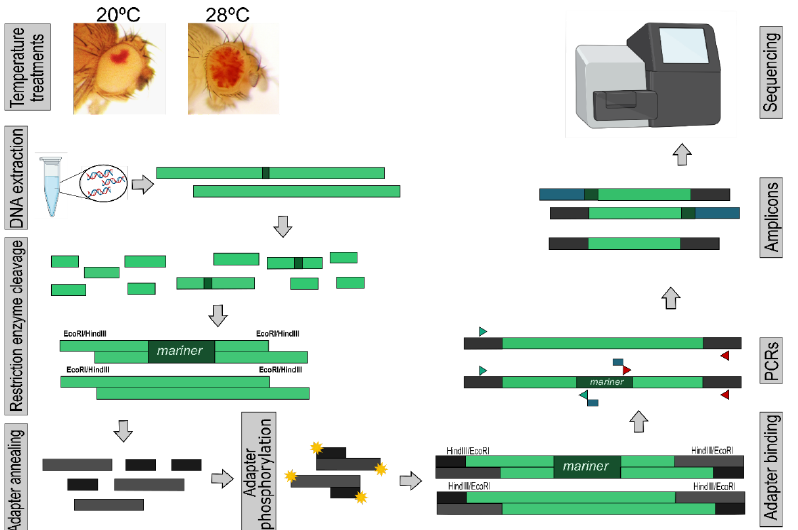
Figure 1. TISseq molecular protocol. This process used to produce the amplicons is described in detail and the steps are indicated by the light grey rectangles, namely: temperature treatments, DNA extraction, restriction enzyme cleavage, adapter annealing, adapter phosphorylation, adapter binding, PCRs, amplicons, and sequencing. The green rectangles represent DNA fragments, including the mariner element. The yellow star represents the phosphorylation process. There are two different adapters: darker grey rectangles represent one and the blue rectangles represent the other. Triangles represent the two primer pairs, as described in Supplementary Table S1. The blue rectangles represent binding at the mariner’s annealed primers and did not anneal at any sequence. They are included in the amplicons by the PCR process. There are three different amplicons being sequenced: two containing mariner (upstream and downstream) and one without mariner removed by bioinformatics